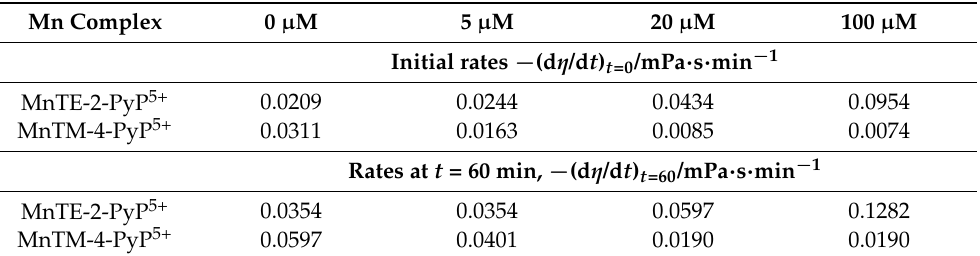
Table 1. The values of initial rates of HA degradation, derived from the time-dependent changes in dynamic viscosity ( η ) of the HA solution subjected to MnTE-2-PyP 5+ or MnTM-4-PyP 5+ at different concentrations and 100 µ M ascorbate in the in the presence of 1 µ M Cu(II). Initial rates − (d η /d t ) t =0 : were listed where Mn porphyrins were added at the start of HA degradation; rates − (d η /d t ) t =60 : Mn porphyrins were added after 60 min of HA